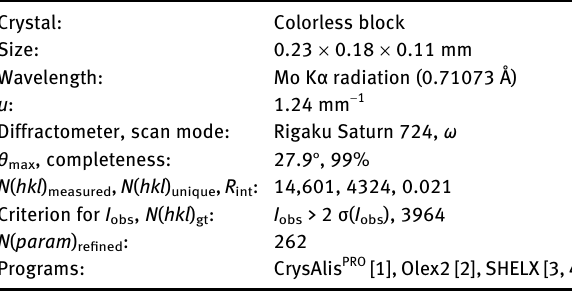
Table 1 contains crystallographic data and Table 2 contains the list of the atoms including atomic coordinates and displacement parameters.